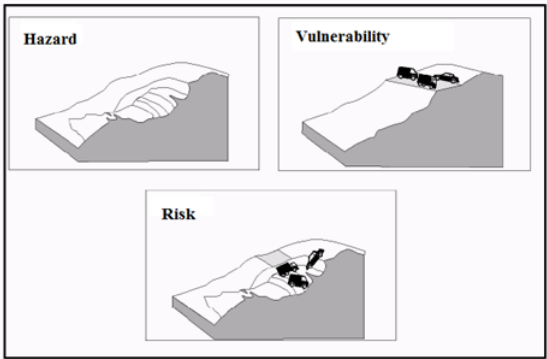
Figure 1: Vulnerability conceptual distinction with hazard and risk in the Landslide Risk Management Research (Source: Varnes and the AEG Commission on Landslide, 1984)